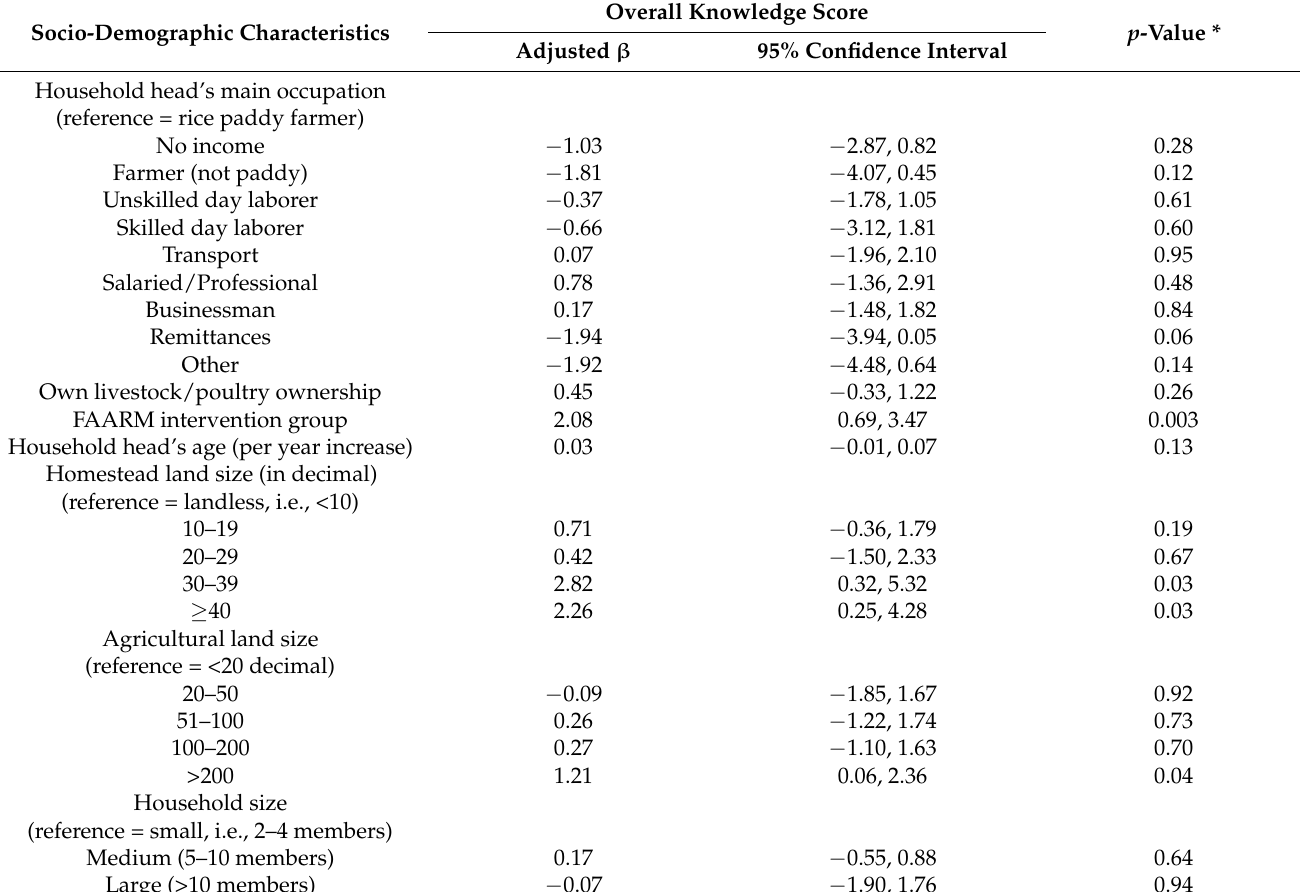
Table 2. Adjusted associations of socio-demographic characteristics with overall mold and mycotoxin knowledge score ( n = 1257). Socio-Demographic